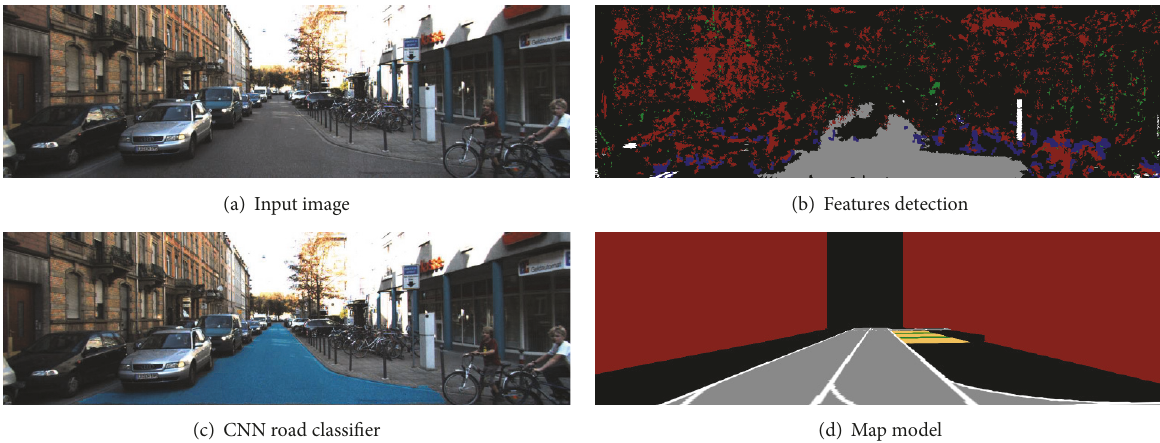
Figure 15: Dynamic obstacles (cyclist and vehicles) are effectively not considered as drivable by the CNN-based road segmentation system. The high-interpretation module maintains the actual structure of the road besides the dynamic